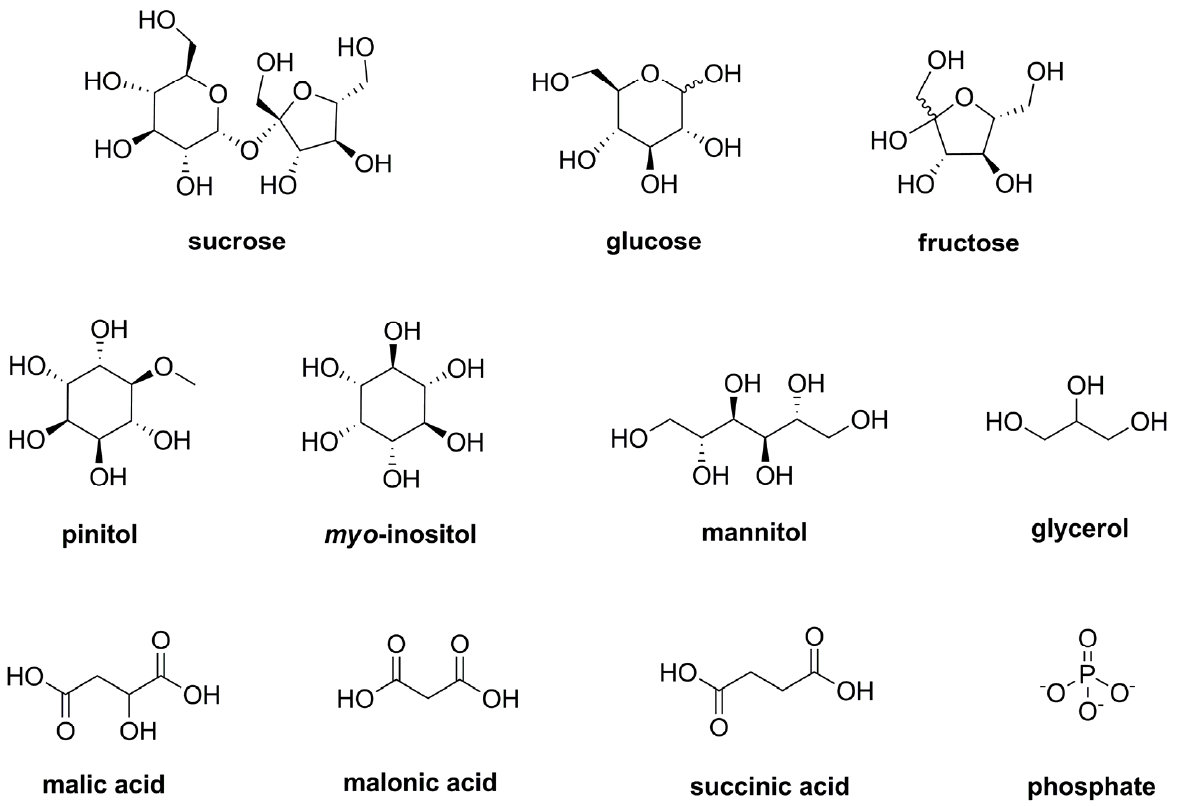
Figure 1. Chemical structures of most dominating primary metabolites.